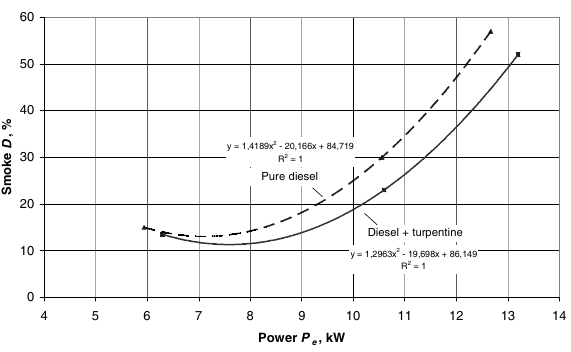
Fig 5. Dependence of exhaust gas smoke on the engine power for run with different fuels 4. Conclusions 1. Addition of 5 % of lighter fuel fractions to diesel fuel reduced engine exhaust smoke by 10…20 % in both Diesel engines. 2. Turpentine easily form mixtures (without any sup- plements) with diesel fuel. 3. Decrease of specific fuel consumption b for diesel e fuel blends with 5 % of turpentine was caused by faster evaporation and combustion of the blend par- ticles as compared with pure diesel fuel. 4. Small amount of turpentine additive to diesel fuel would increase the cost of the fuel blend only by 3…5 %